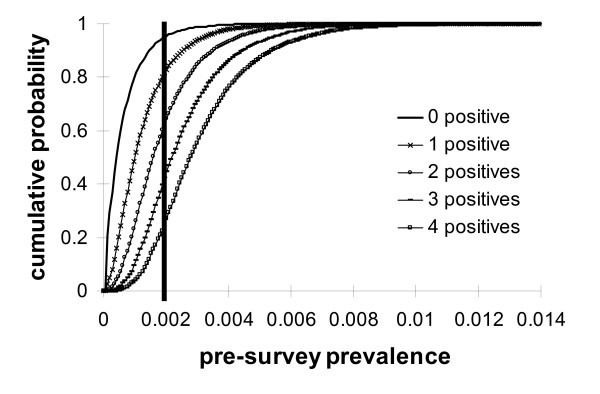
Cumulative probability distribution of pre-survey prevalence with increasing numbers of positive samples detected. Effect of increasing residual herd prevalence (HP) on the pre-survey prevalence estimates prior to the consecutive survey at a threshold HP of 0.2% (vertical black bar). Pre-survey herd prevalence was estimated using cumulative herd prevalence beta-distributions defined by a fixed sample size (N = 2400) and increasing numbers of positive samples